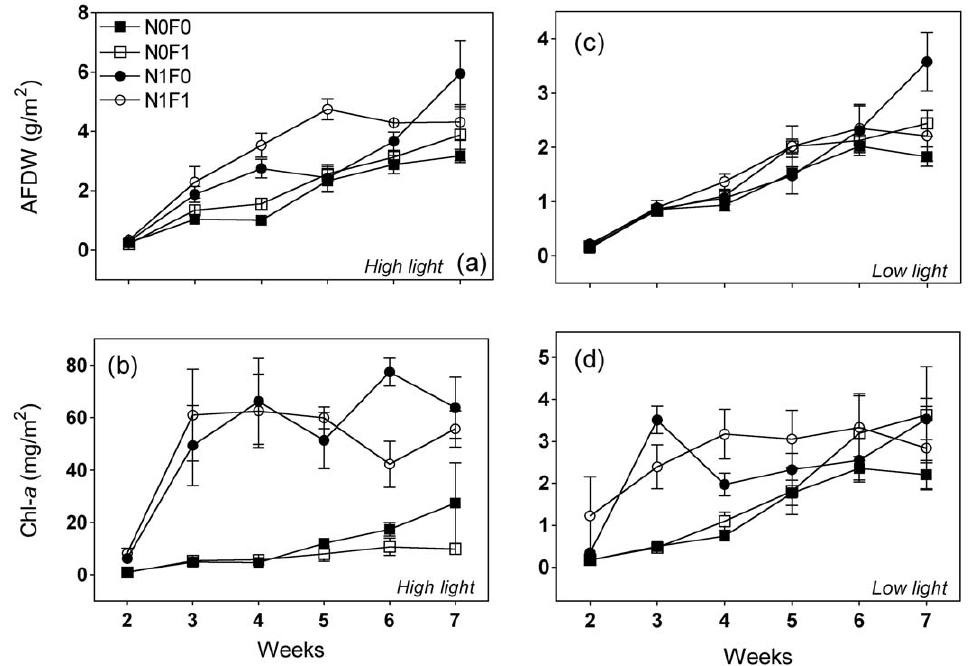
Figure 2. Periphyton total biomass (top – a and c) and algal biomass (bottom b and d) over the time at different light regimes (High light – a and b; Low light – c and d). Treatment abbreviations are the same as in figure 1. Circles indicate enriched treatments and unfilled symbols indicate presence of fish. Data are means 6 SE. For statistical differences see the text.. Note the differences on Y-axis scales for each graph.